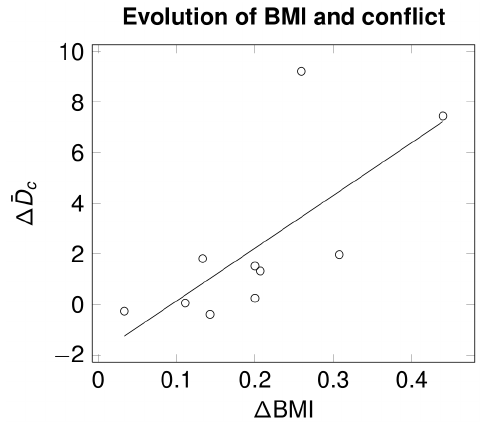
Figure 2. Correlation between the changes in BMI and conflictual communication. Change in BMI is D BMI ~ (BMI( Sf ) { BMI( Si )) = BMI( Si ) . Change in conflictual commu- nication is D (cid:2) DD c ~ ( (cid:2) DD c ( Sf ) { (cid:2) DD c ( Si )) = (cid:2) DD c ( Si ) . Experimental data (circles) and the regression line are depicted on the figure.